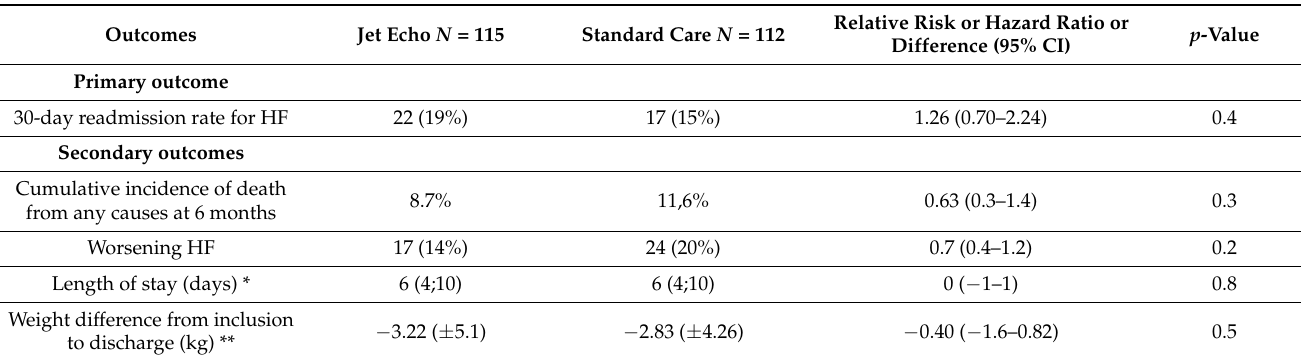
Table 2. Primary and secondary outcomes.